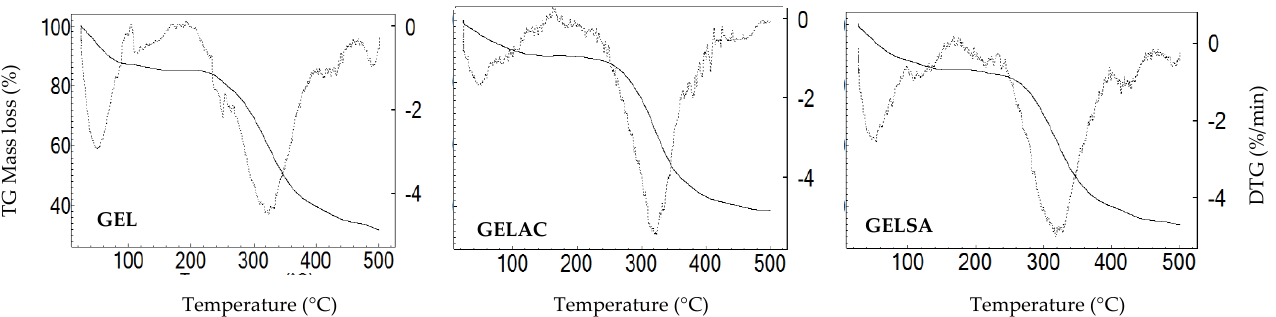
Figure 7. Thermogravimetric (TG, mass loss %) and derivative of thermogravimetric (DTG, %/min) curves of the GEL, GELAC, and GELSA biomembranes, at temperatures up to 500 °C.